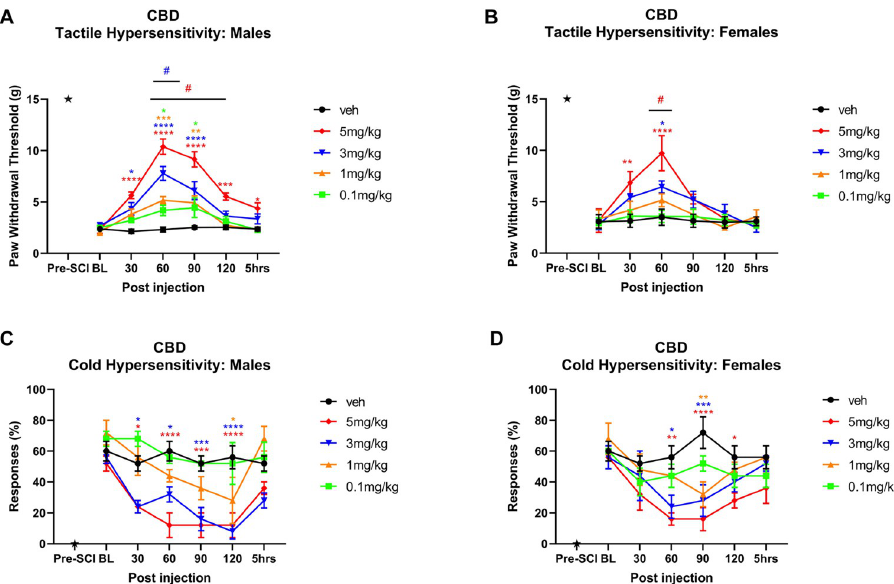
Fig 1. Time course of CBD antinociceptive effects in male and female rats. Time plots of the effects of CBD (0.1, 1, 3 or 5 mg/kg) and matched vehicle on mechanical PWT in A) males and B) females, and acetone responses in C) males and D) females (n = 5–6 per treatment group). Animals were tested starting at 4 weeks post-SCI; pre-SCI baseline responses are also displayed as indicated by the star. � , �� , ��� , ���� denote p < 0.05, 0.01, 0.001 and 0.0001 compared to vehicle for each treatment group. # denote p at least < 0.05 between 5mg/kg (red #) and lower concentrations of CBD or 3mg/kg (blue #) and lower concentrations of